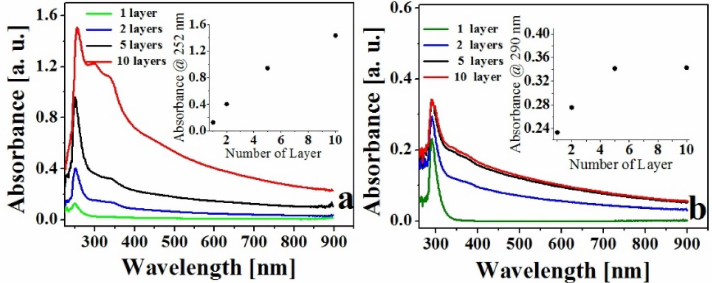
Figure 10. UV–VIS absorption spectra of LB films with 10 layers: ( a ) 2b and ( b ) 4b . Inset: Absorbance versus the number of layers at: ( a ) 252 nm and ( b ) 290